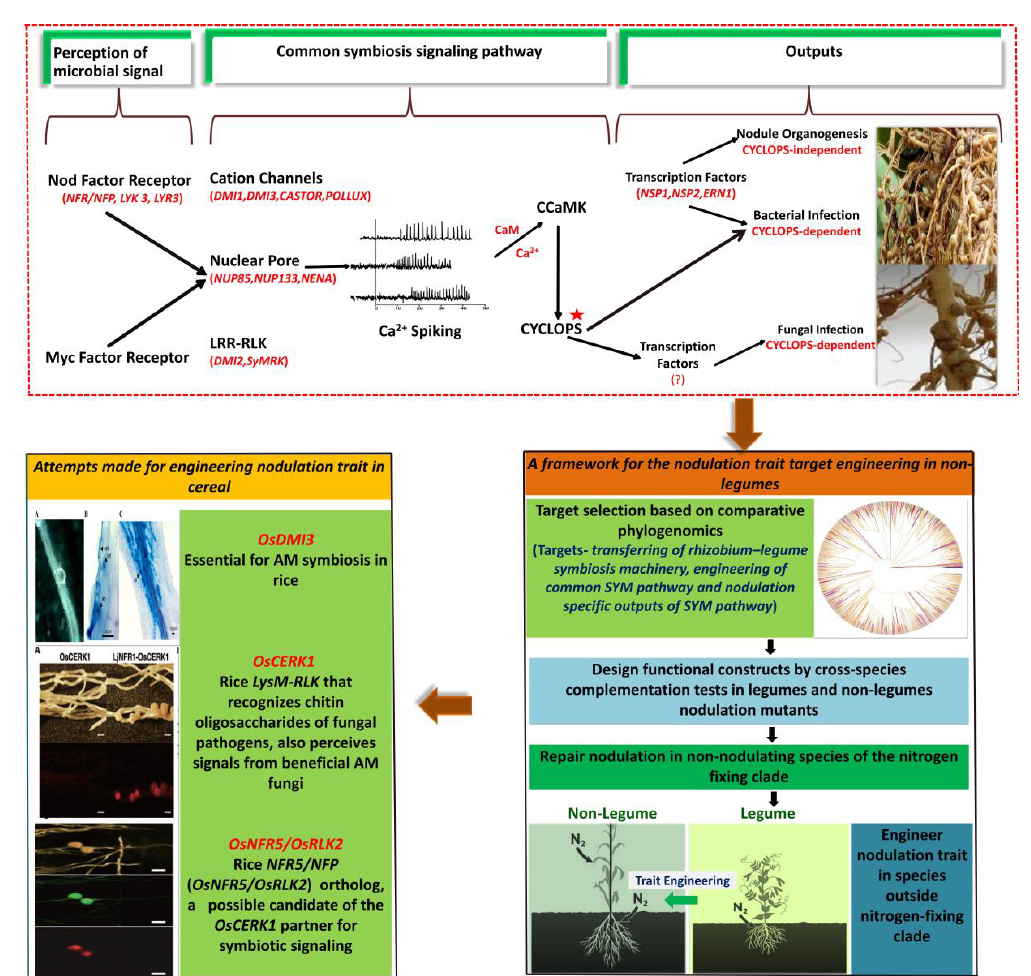
Figure 1. Schematic diagram representing the current advancement, opportunities towards understanding the nitrogen metabolism, root nodulation mechanism, and their implementation in non-legume crop plants.